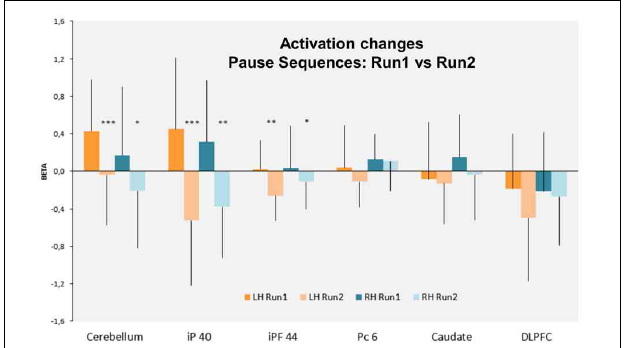
FIGURE 6 | Bars graph indicating the rCBF changes (Beta) in the cortical and subcortical ROIs defined in the left and right hemispheres (LH and RH, respectively). Note that only the cerebellum and the inferior parietal cortex BA40 (iP 40) and to a less extent the inferior prefrontal cortex BA 44, are the most activated bilaterally during run 1 and significantly decrease their activity during run 2. Bars: standard deviation. iP 40: inferior parietal cortex